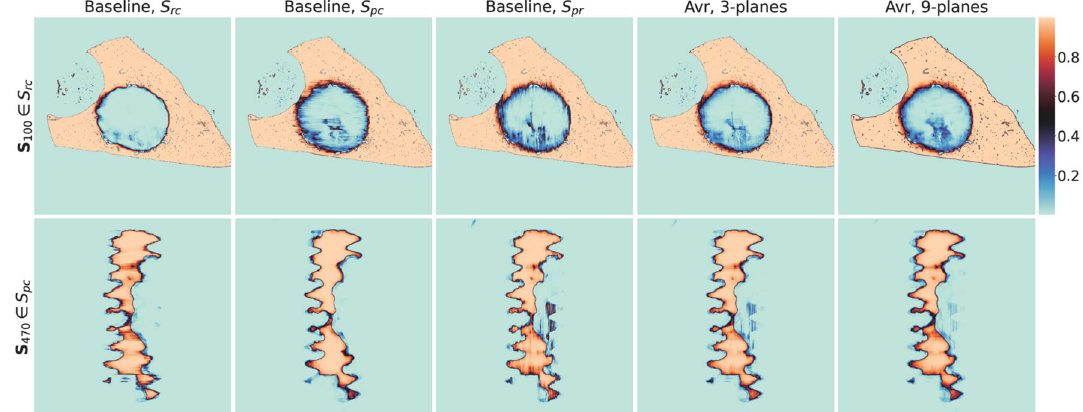
Figure 4. Probability results for processing the 3D volume slice-by-slice and the proposed soft voting fusing method. Here, we show S 100 ∈ S rc and S 470 ∈ S pc (in the first and second row, respectively) of the test sample 1. For S 100 ∈ S rc , each image shows the probability output for “bone” of our best model without conversion to a final segmentation. For S 470 ∈ S pc , we show the probability output for “residual material”. From left to right: “Baseline, rc”, “Baseline, pc”, “Baseline, pr”, “Avr, 3-planes”, and “Avr, 9-planes”. A high value indicates that this area is most likely “bone” or “degradation layer” for S 100 ∈ S rc and S 470 ∈ S pc , respectively.